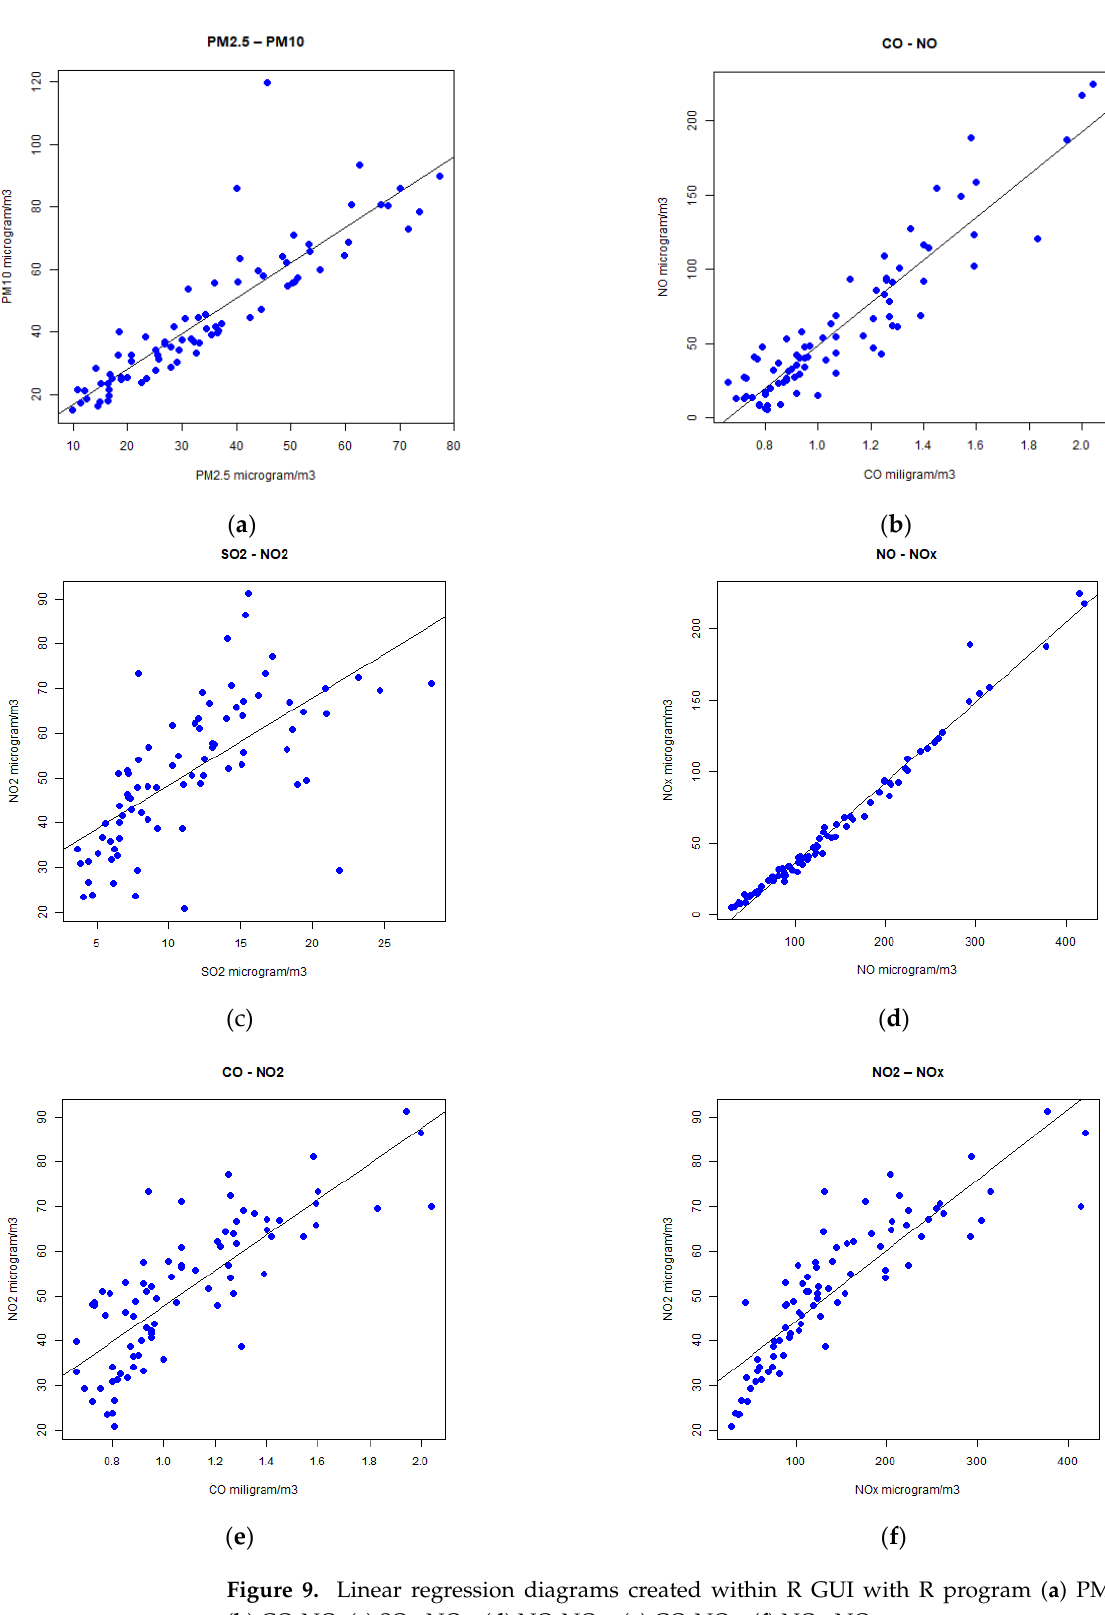
Table 2. Summary statistics from linear regression model for CO and NO. Y = 143.66x - 94.94